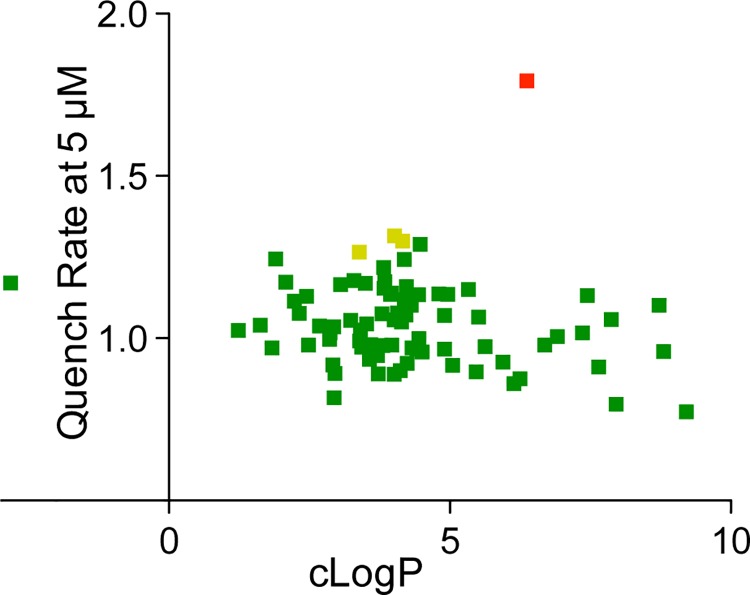
The Malaria Box compounds’ estimated hydrophobicity (clogP) is not correlated with lipid bilayer effects.Plot of the quench rate (relative to control) vs. cLogP, which was calculated using the ALOGP algorithm [44] as implemented by Collaborative Drug Discovery, Inc. (http://collaborativedrug.com, Burlingame, CA). MMV007384 (red dot cLogP = 6.37); from L to R (amber dots): MMV020548, cLogP = 3.39; MMV020549, cLogP = 4.16; and MMV019258, cLogP = 4.01.